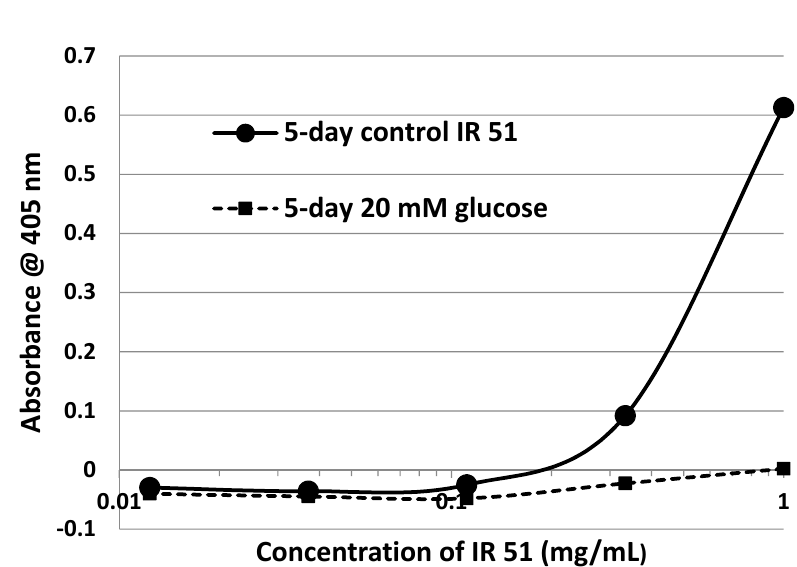
Figure 8. Insulin–HRP binding to insulin receptor peptide (IR) 51–61 in the absence and presence of glucose over six days. Moderate glycation in 20 and 60 mM glucose reduces the binding constant by a factor of approximately 2. Extreme levels of glycated peptide resulting from incubation in medium containing 200 mM glucose reduce binding capacity to nearly undetectable levels.